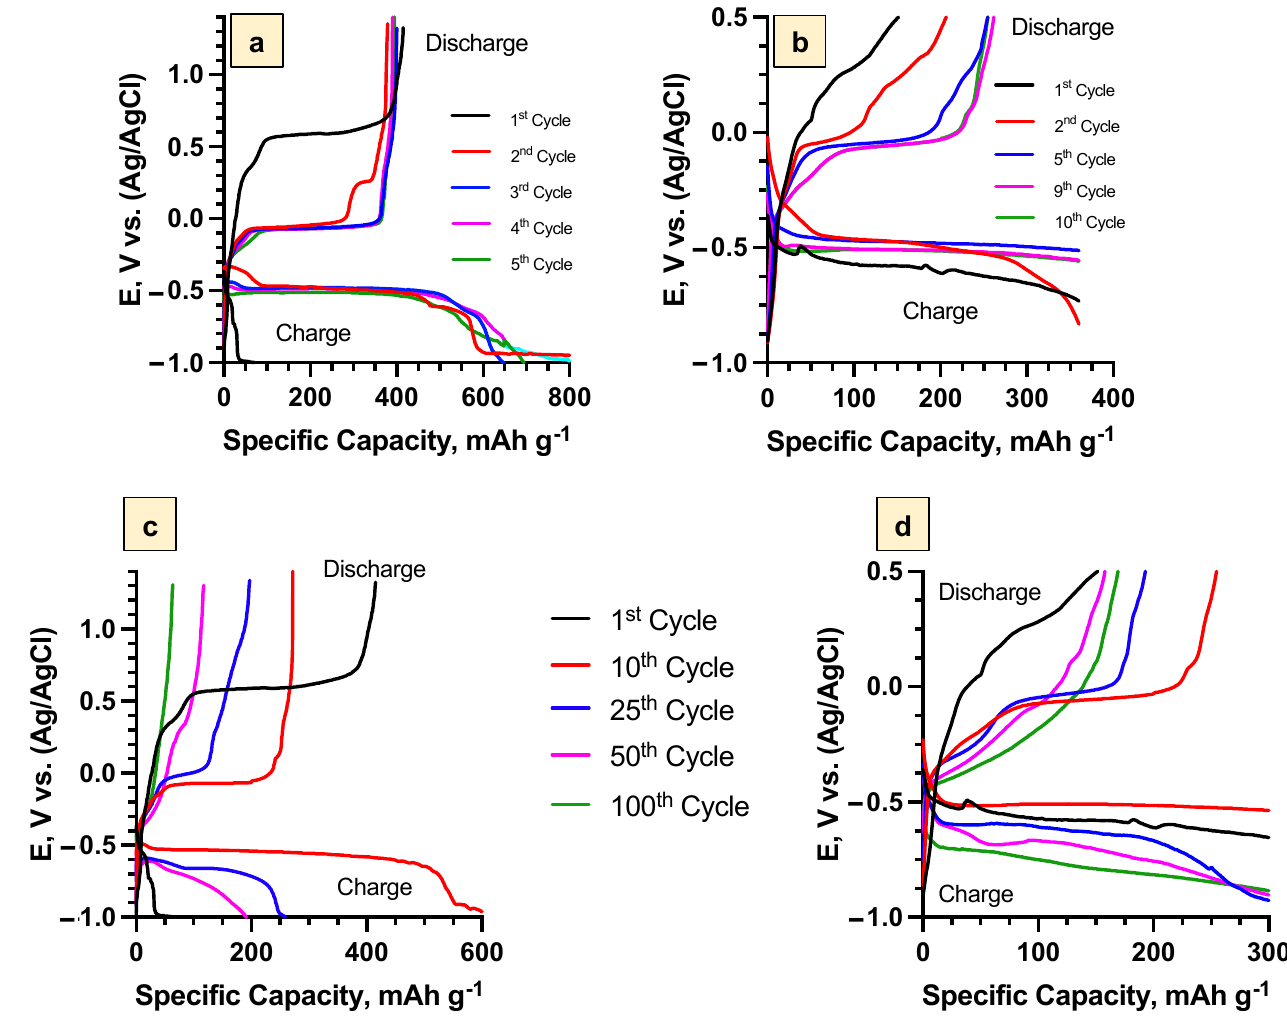
Figure 3. Charge/Discharge profiles of Bi 2 Se 3 thin films in 5 M LiNO 3 at 1 C: ( a )—first 5 cycles for the SEI layer ( − 1.0 V ÷ 1.3 V), ( b )—first 10 cycles for the Bi 2 O 3 layer ( − 1.0 V ÷ 0.5 V), ( c )—profiles up to the 100th cycle for the SEI layer ( − 1.0 V ÷ 1.3 V), ( d )—profiles up to the 100th cycle for the Bi 2 O 3 layer ( − 1.0 V ÷ 0.5 V).